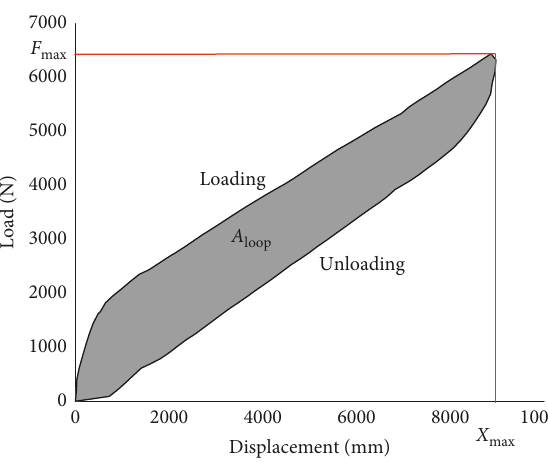
Figure 1: The typical load-displacement curve of the